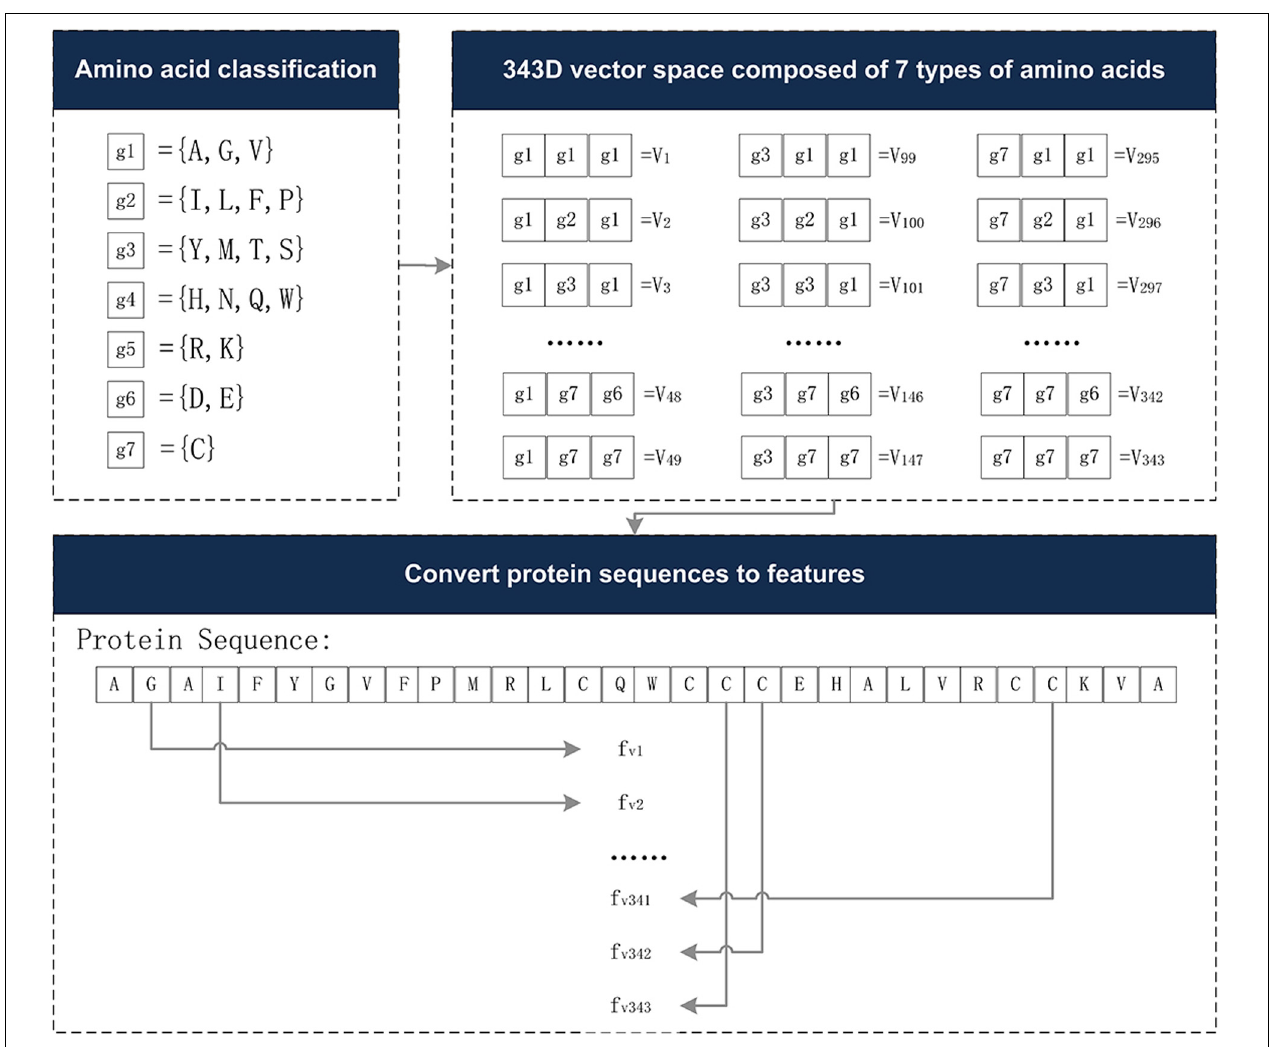
FIGURE 2 | The 343-dimensional feature composition diagram. (1) Classify 20 amino acids into seven categories and obtain the g1 ∼ g7, as shown in the amino acid classification part. (2) In the 343D vector space composed of seven types of amino acids, the seven amino acids were arranged and combined, resulting in 343 trimmers. (3) Examples of sequence conversion into features. The figure was adapted from the Supplementary Figure in Shen et al.